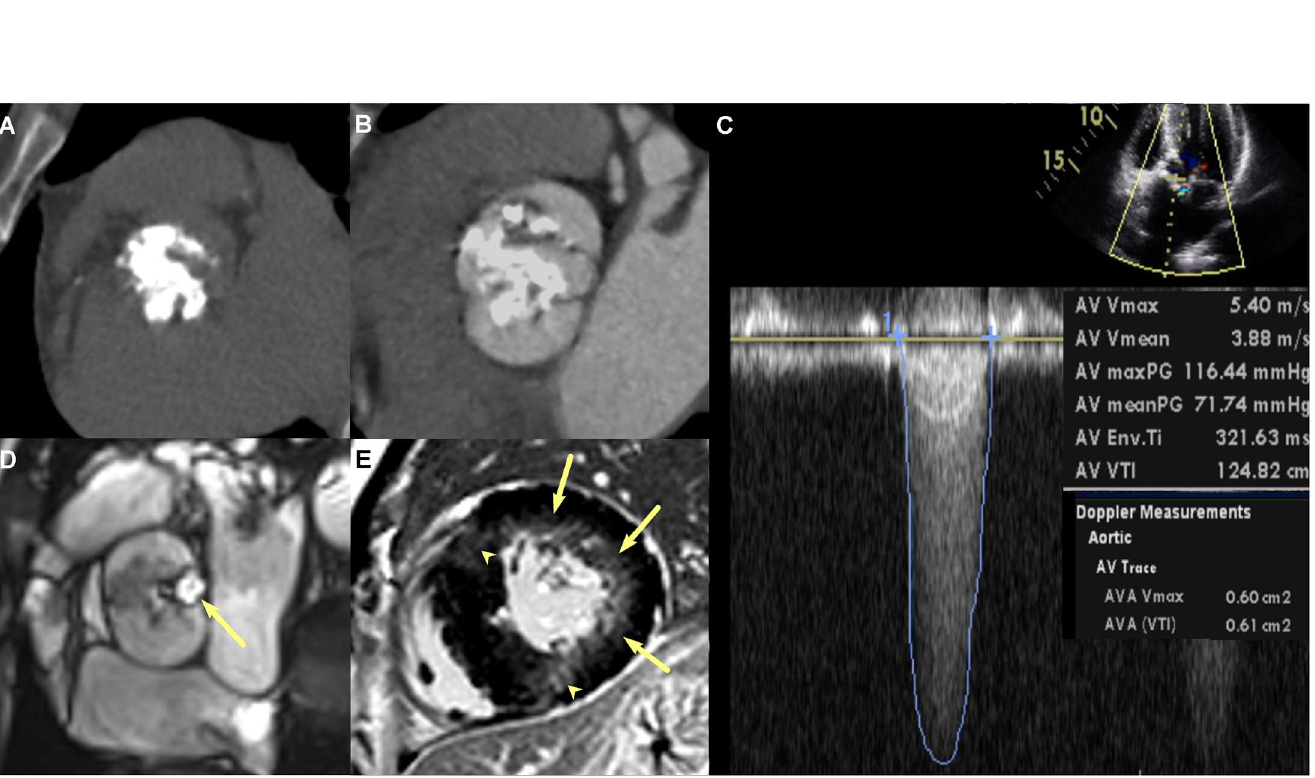
Fig 3. Multi-modalities images of a 45-yearold man with severeaortic stenosis (AS), mild aortic regurgitation, and myocardial fibrosis (MF). a and b Cardiac computed tomographyimages demonstrate calcifiedAS (aortic valve calcification grade 4, aortic valve calcium score 7650, and aortic valve area 0.83cm 2 ) and bicuspidaortic valve without raphe. c Transthoracic echocardiography image demonstrate severe AS (aortic valve area 0.61cm 2 ), peak aortic velocity 5.4m/sec, and mean pressure gradient71.7mmHg. d and e Cardiac magneticresonanceimages demonstrated severe AS (aortic valve area 0.71cm 2 , arrow in d ), left ventricular (LV) hypertrophy, LV end-diastolic volume index 84ml/m2, LV end-diastolic mass 268g, LV ejection fraction of 56%, presenceof MF appearingdelayedhyperenhancement in the subendocardial region of the lateral wall (arrows, e ) and in the transmural region of the anterior and inferior wall of the mid-ventricular myocardium(arrowheads, e